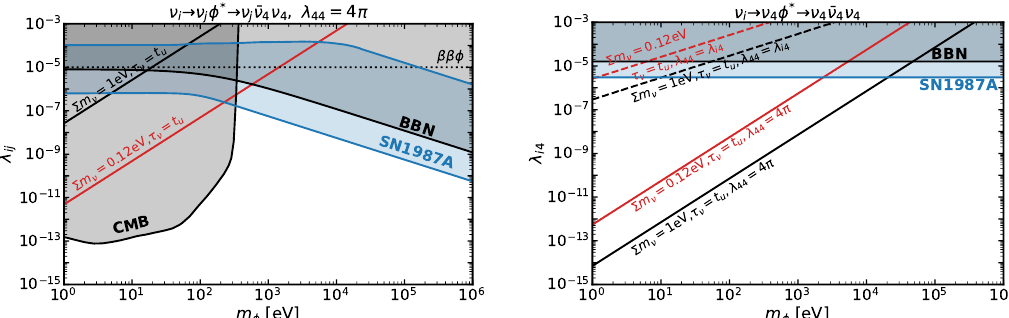
Figure 7 . Left panel: parameter space for ν i → ν j φ ? → ν j ¯ ν 4 ν 4 decays (case 3a1 in figure 1). We have assumed that m ν = 0 and that active neutrinos have universal couplings to φ . Right panel: 4 parameter space for ν i → ν j φ ? → ν 4 ¯ ν 4 ν 4 decays (case 3s in figure 1). We show laboratory bounds from KamLAND-Zen [85], CMB constraints on ν - φ interactions from Planck CMB observations [75], and SN1987A and BBN constraints on neutrinophilic bosons — see appendix E for the derivation of the latter two. Note that for decays happening at the same rate, the difference in the final phase space enforces larger couplings for increasing active neutrino mass if one active neutrino is in the final state, whereas the opposite occurs in the case with only sterile final states. Identical conclusions can be drawn for both scenarios but mediated by a Z 0